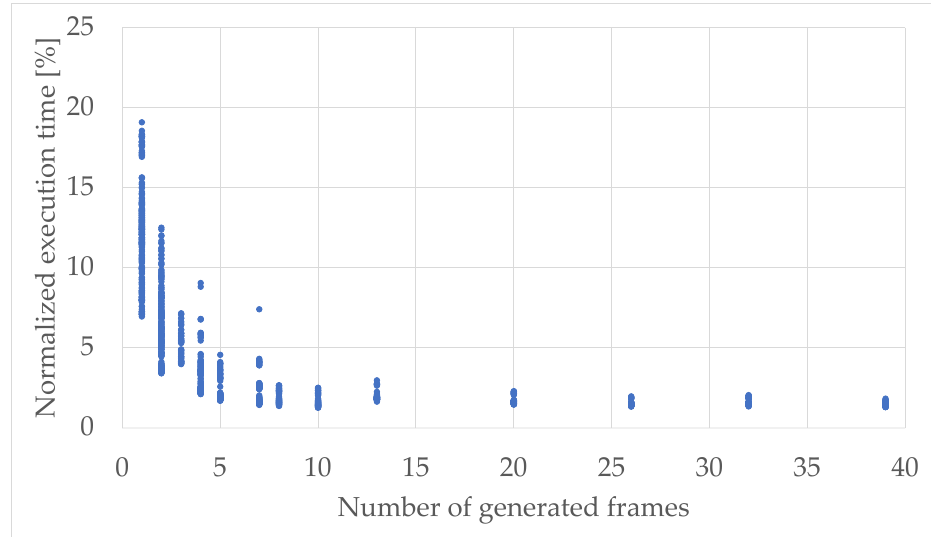
Figure 7. Normalized execution time of all the modules except the OFDM generation as a function of the generated number of radio